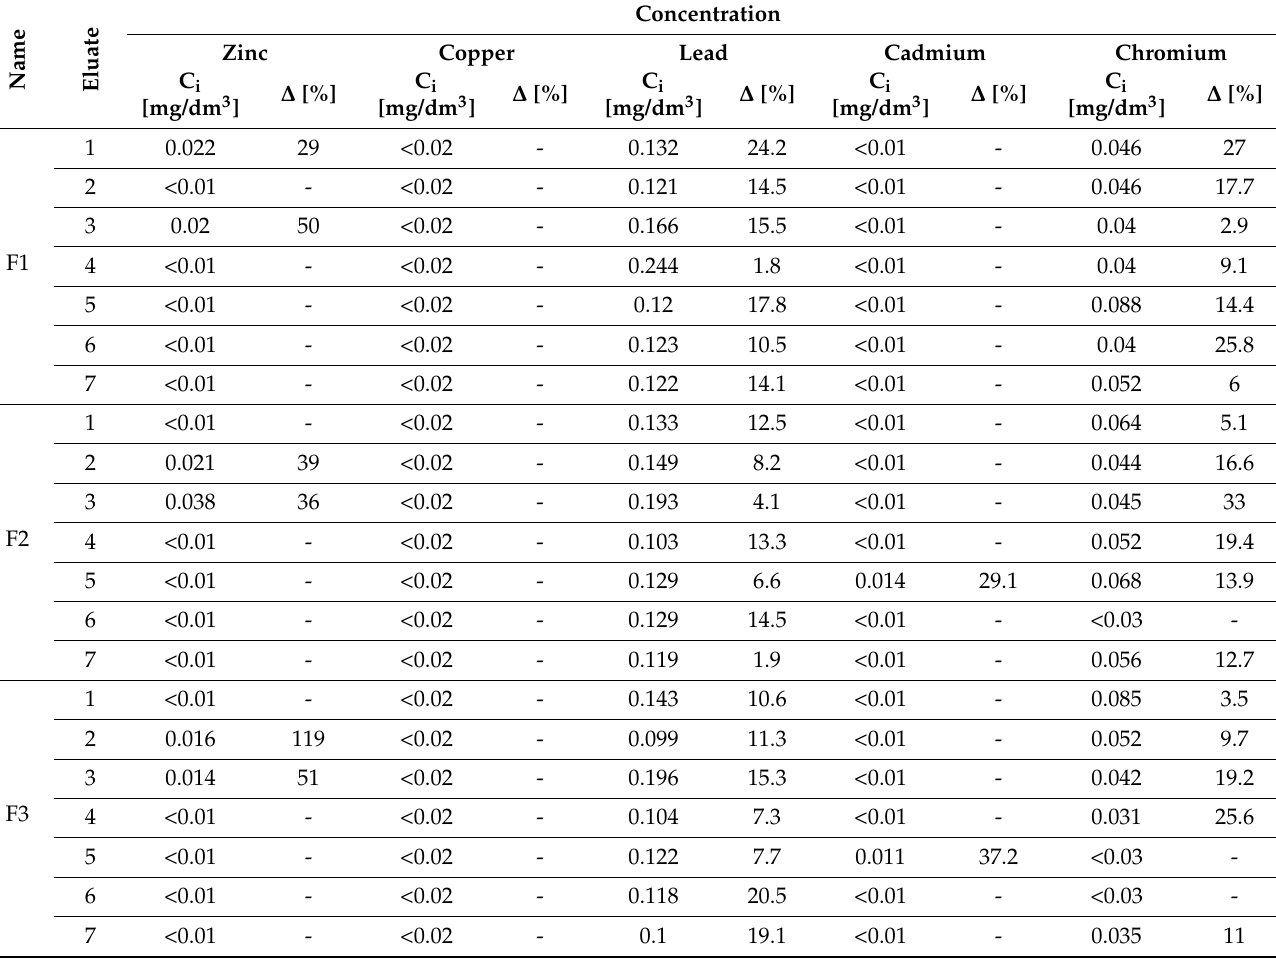
Table 7. Heavy metal concentrations in